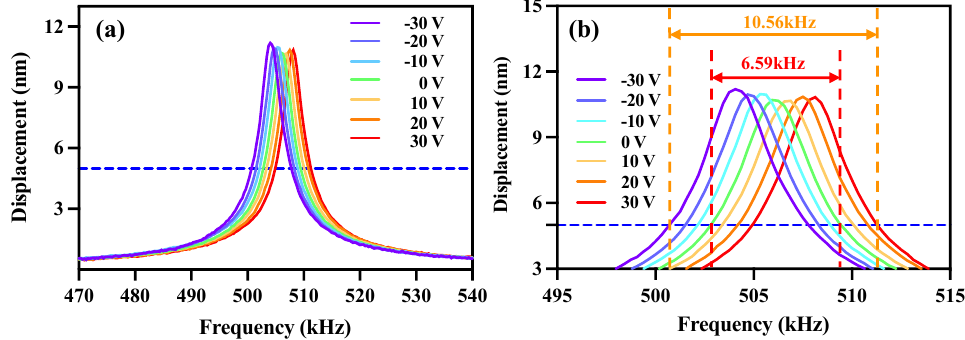
Figure 4. The frequency response curves of the PMUT array for a DC bias voltage range of − 30 to 30 V: ( a ) full view; ( b ) local view.